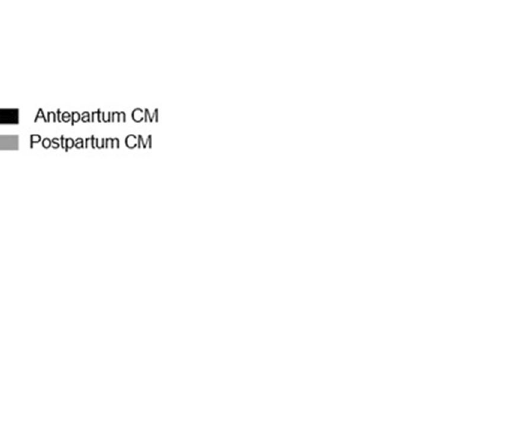
Figure 1. The common bile duct showed cystic dilatation (CCC) on US ( a ) and MRI ( b ) in a prepartum diagnosed CM patient after birth.